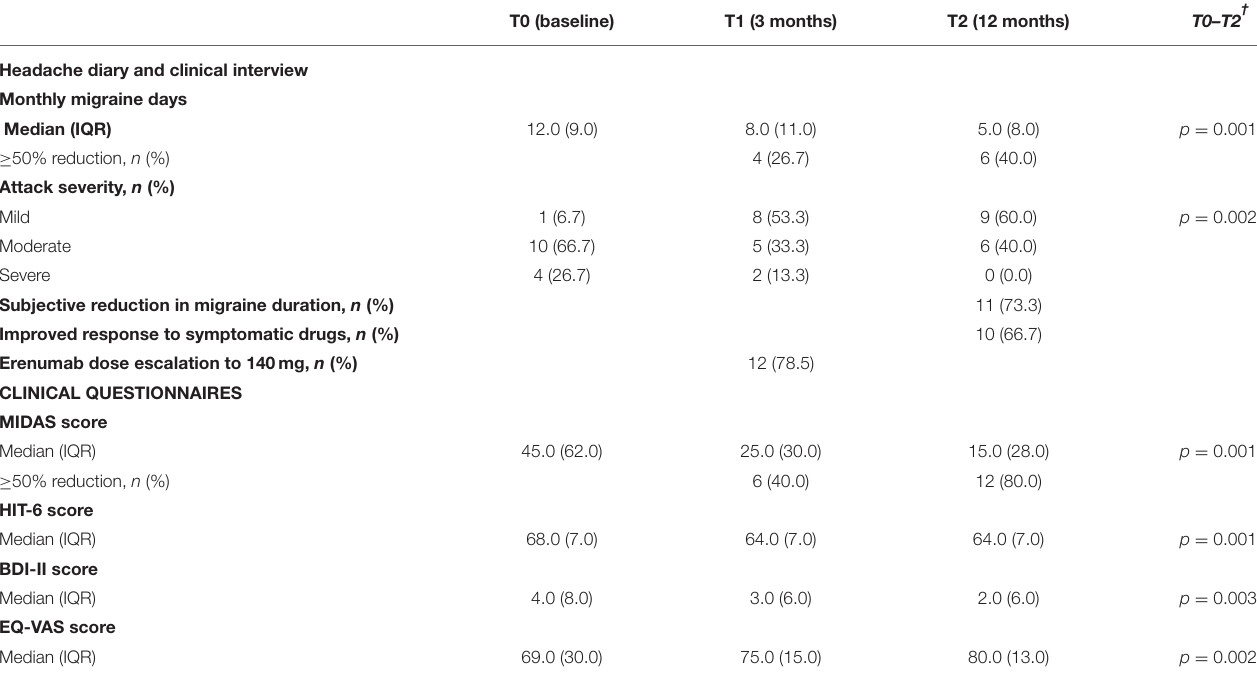
TABLE 4 | Erenumab effect on migraine after 12 months of treatment ( n =